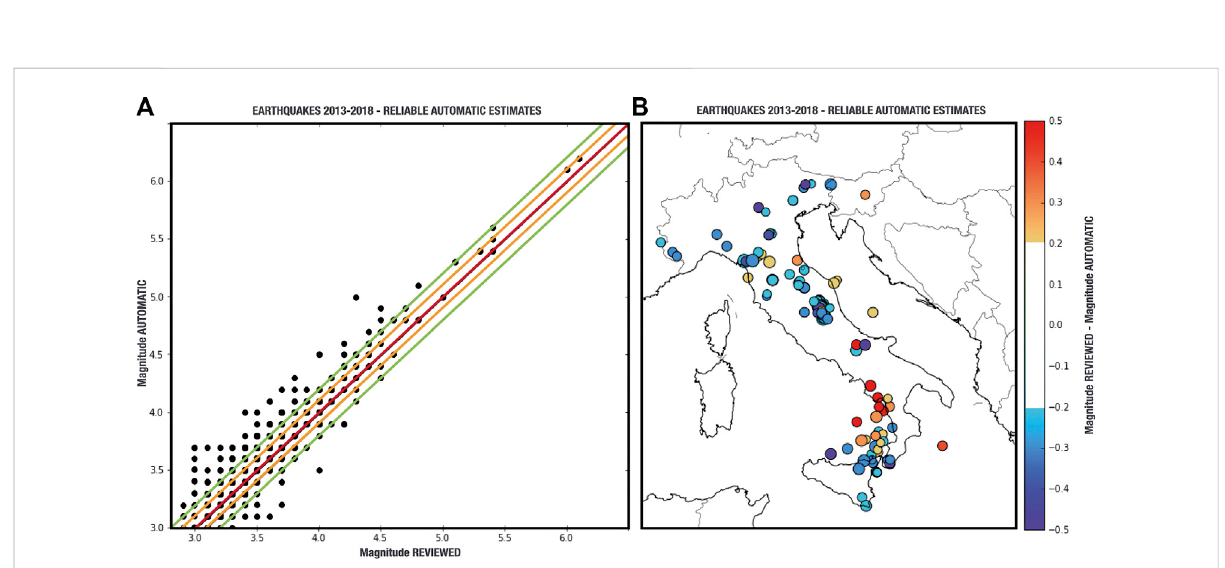
Analysis of the difference between automatic and manually revised magnitude for reliable automatic estimates (A) Distribution of reviewed magnitude of reviewed M L vs. automatic M L , the lines highlights difference with 0.1 step (B) map of automatic reliable estimates with difference in magnitude greater than 0.2, higher differences correspond to deep events located on the subduction of the Calabrian Arc that usually shows higher error in the automatic